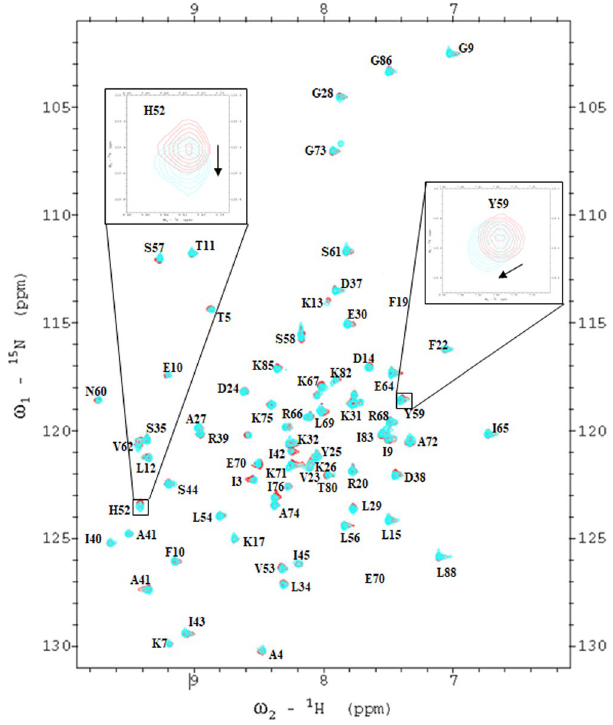
Figure 4. 1 H- 15 N NMR spectra of MTH before (red) and after 20 min plasma treatment (cyan). The major differences are enlarged in the insets.